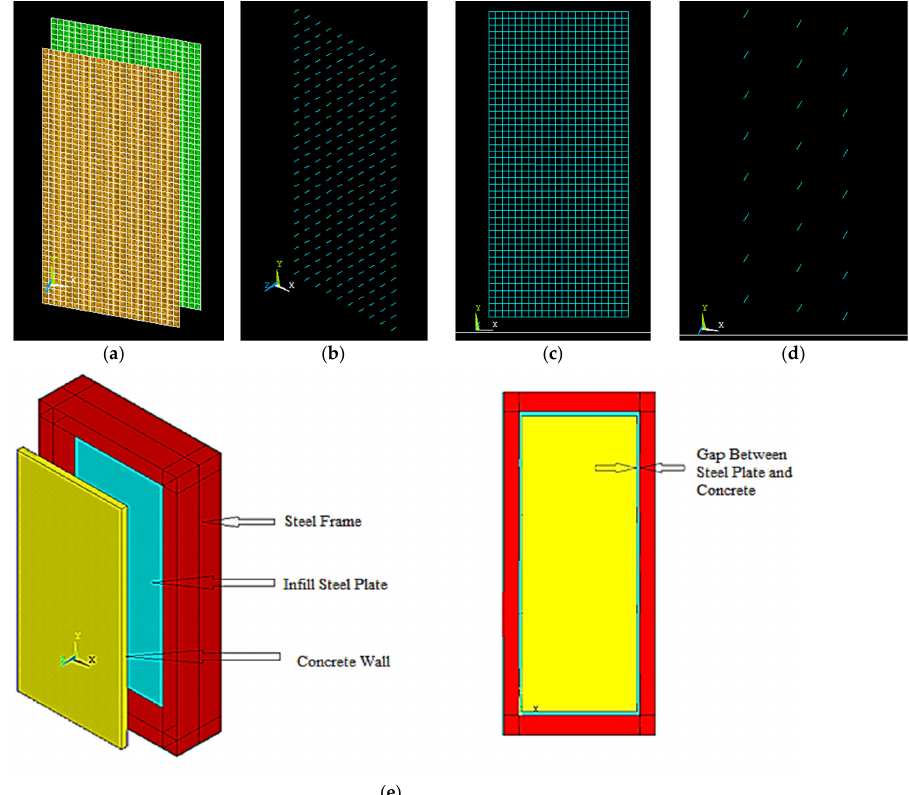
Figure 3. Contact between different elements: ( a ) interface surface; ( b ) load slip; ( c ) reinforcement; ( d ) shear stud; ( e ) assembled FEM.